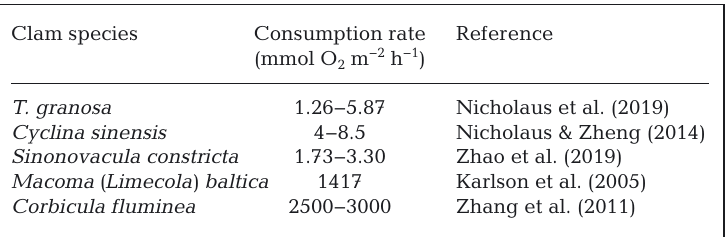
Table 4. Evidence from the literature for sediment oxygen consumption by bivalve clams (including Tegillarca granosa ) in aquatic